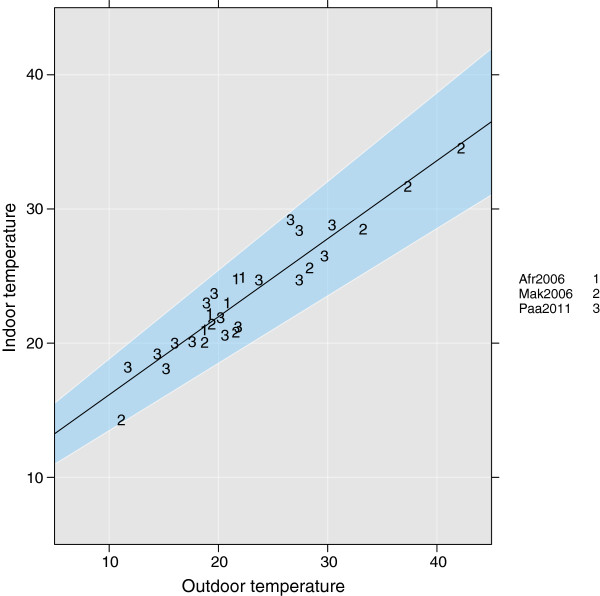
Relationship between outdoor and indoor temperatures. Numbers denote the study from which data were taken: 1, Afrane et al. [48]; 2, Makaka and Meyer [117]; and 3, Paaijmans et al. [114-116]. The blue area represents the 95% confidence interval, and the black line shows Eq. 36. R2 = 0.89.